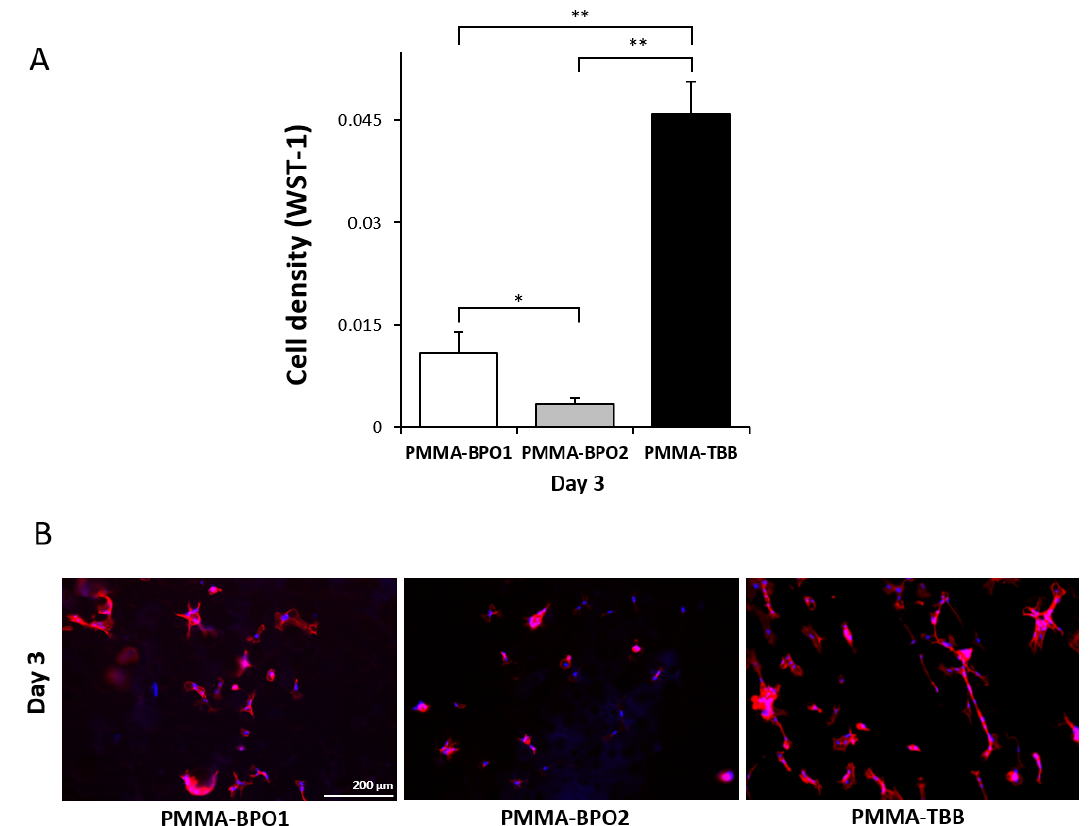
Figure 2. Proliferation of osteoblasts on the three different bone cement surfaces during the mid-stage of the culture. ( A ) The number of cells attached to the surface of each material at day 3 of incubation, evaluated using a WST-1 assay. ( B ) Visualized osteoblasts 3 days after seeding on the material. Representative fluorescence microscopy images of cells stained with rhodamine phalloidin for actin filaments (red) and DAPI for nucleus (blue). Each value represents the mean ± standard deviation of triplicate experiments ( n = 3). * p < 0.05, ** p < 0.01, one-way ANOVA followed by a Bonferroni test. Scale bar = 200 µm.